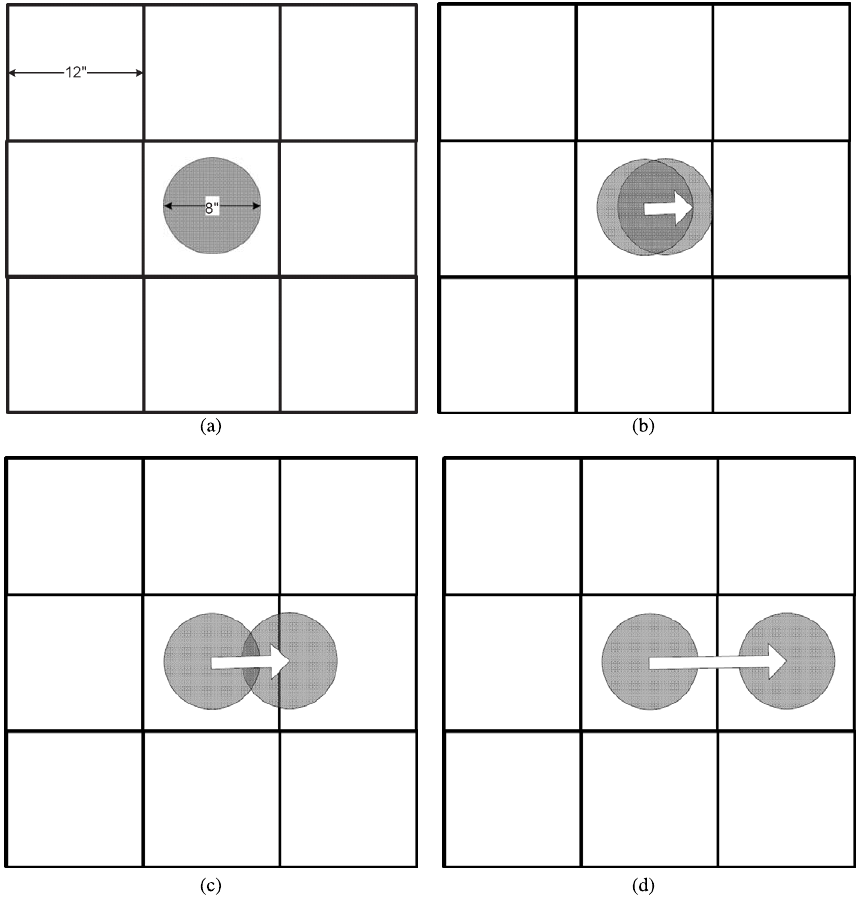
Fig. 5. (a) Obstacle position before collision. (b) Type I collision. (c) Type II collision. (d) Type III